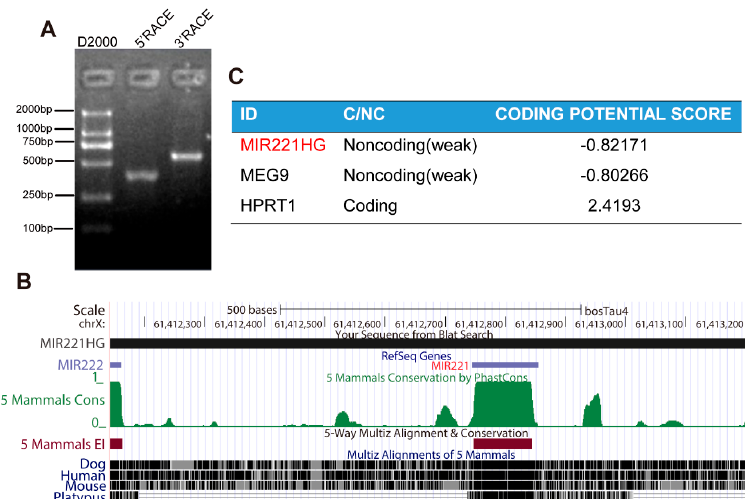
Figure 2. ( A ) The 5 ′ rapid amplification of cDNA ends (RACE) and 3 ′ RACE analyses illustrated that MIR221HG is a transcript of 1640 nucleotides with one single exon. ( B ) Genome structures of MIR221HG. Sequence conservation of MIR221HG was measured by multiple alignments of five vertebrate species using the UCSC Genome Browser. ( C ) The Coding Potential Calculator (CPC) program was used to evaluate the coding potential of MIR221HG, maternally expressed gene 9 (MEG9), and hypoxanthine phosphoribosyltransferase 1 (HPRT1), and both MIR221HG and MEG9 were predicted to be non-coding RNAs, while HPRT1 was identified to code for protein. 3.3. Multiple FOXC1 and KLF5 Binding Sites Are Present in the MIR221HG Promoter Region Gene expression is regulated by a complex network of transcription factors. Analysis using the online database JASPAR showed that the MIR221HG promoter region contains binding sites for many adipocyte differentiation-related transcription factors, such as forkhead box C1 (FOXC1), Kruppel-like factor 5 (KLF5), specificity protein 1 (SP1), signal transducer and activator of transcription 1 (STAT1), and C/EBP α . Notably, there are six FOXC1 binding sites and two KLF5 binding sites within a 2000-bp region of the MIR221HG promoter (Figure 3), and the sequences of these bindings sites are highly conserved, suggesting that MIR221HG may be tightly regulated by FOXC1 and KLF5.